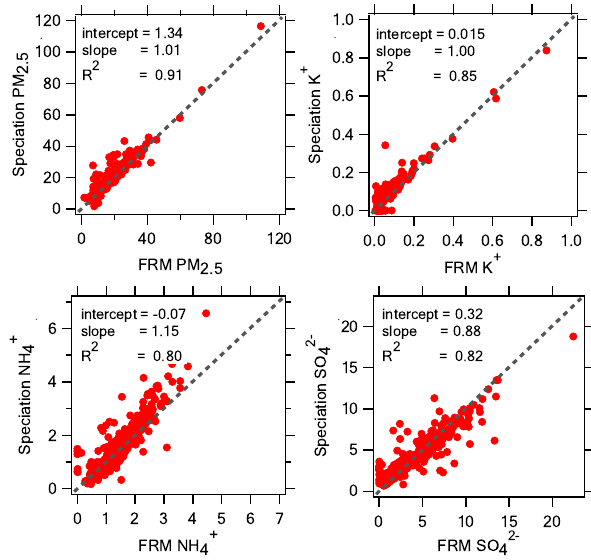
Fig. 3. Intercomparison of PM 2 . 5 mass, K + , NH + trations (in µg/m 3 ) between seven co-located EPA FRM and Speci- ation sites. FRM K + , NH + the analysis of all sites presented in this study. In all cases N =